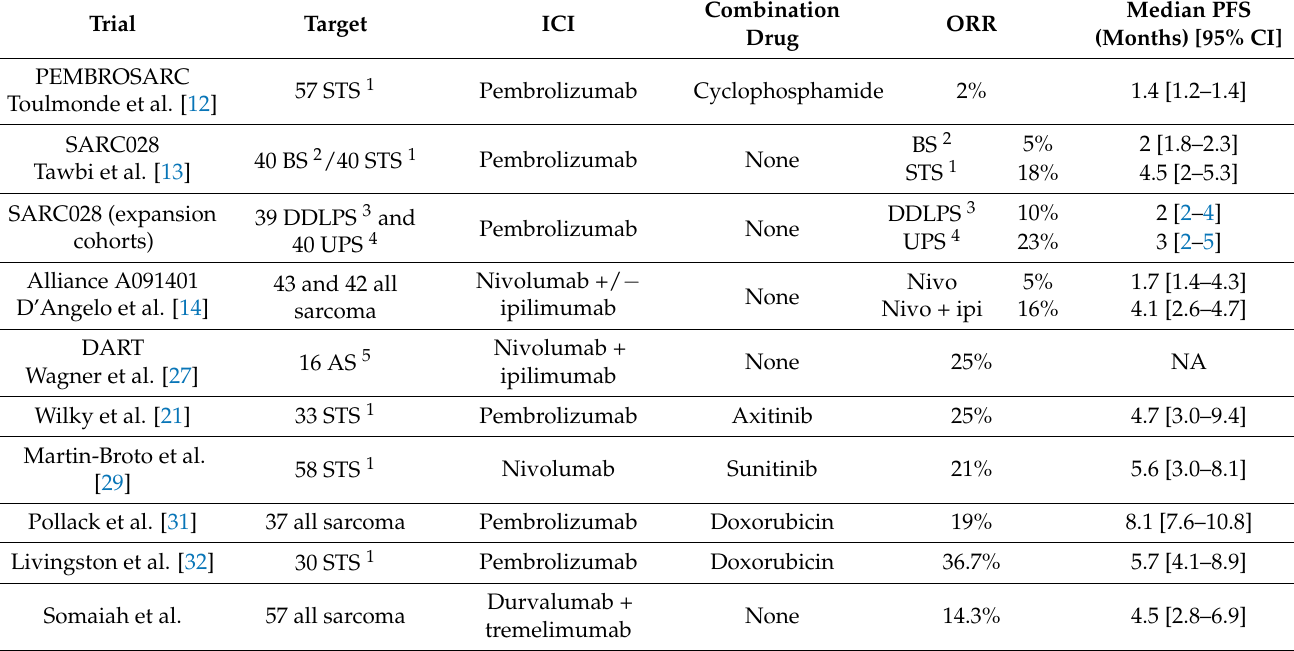
Table 1. Responses to checkpoint inhibitors and combinations in